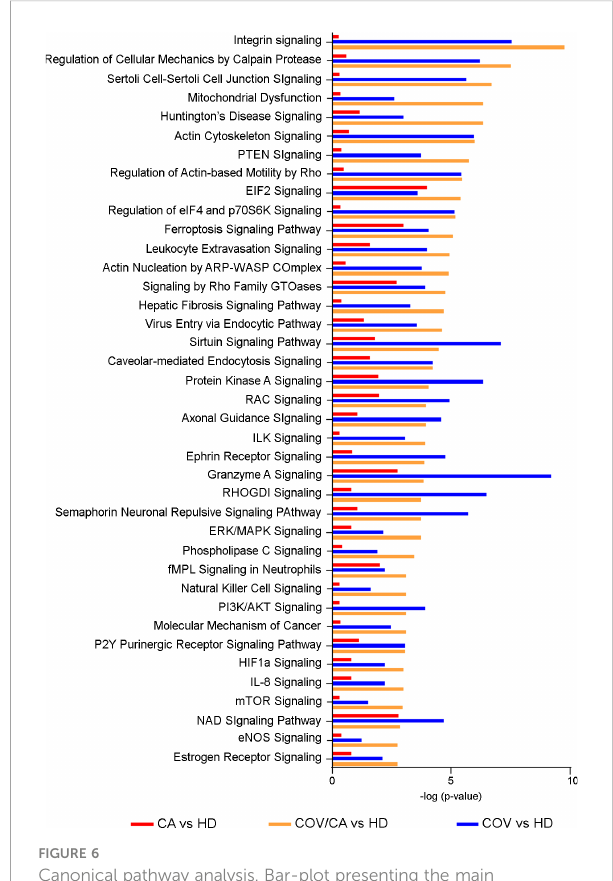
FIGURE 6 Canonical pathway analysis. Bar-plot presenting the main modulated canonical pathways (-log(p-value)) related to PBMCs proteins in COV/CA (yellow bar), COV (blue bar) and CA (red bar) compared to healthy